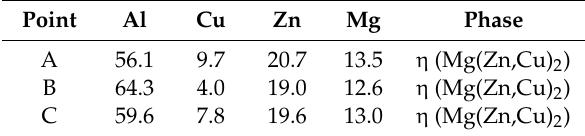
Table 4. Chemical composition of grain boundary precipitates in Figure 5 (at%).